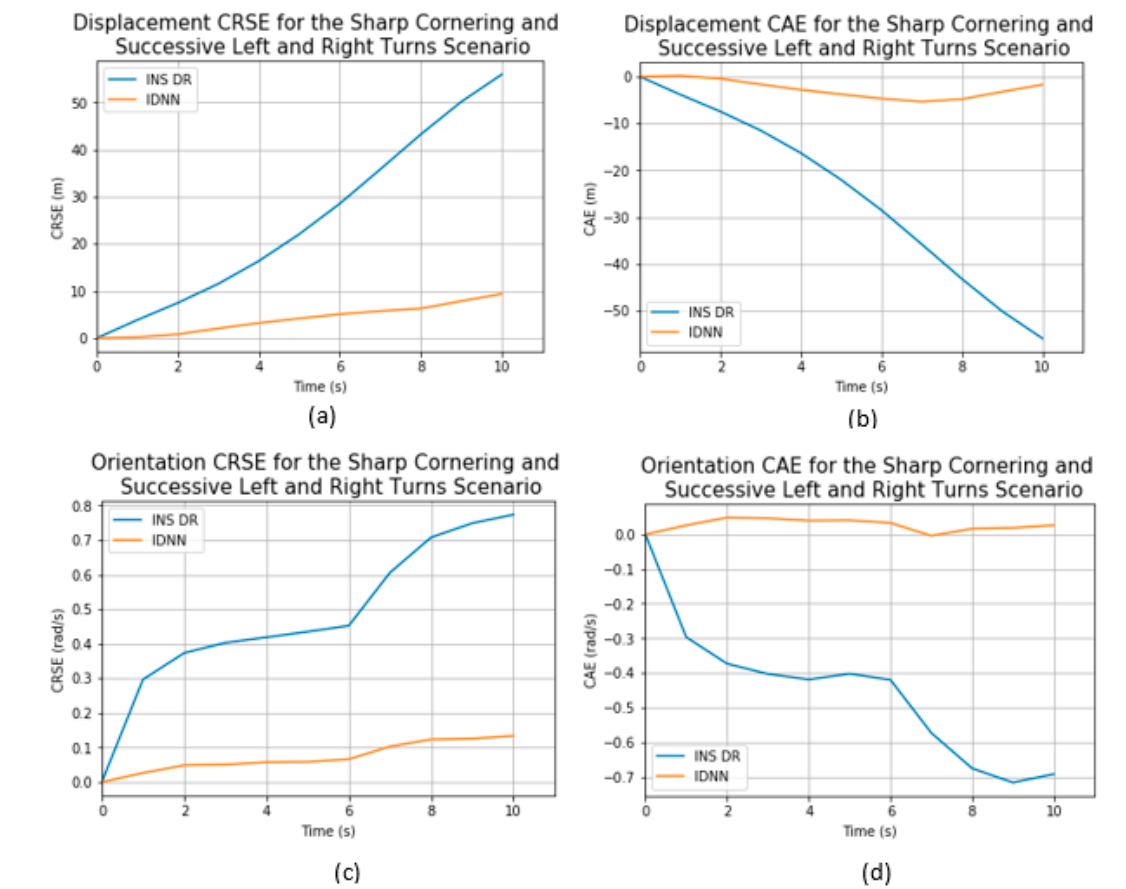
Figure 12. Showing the evolution of the estimation error over time in the hard brake scenario based on the ( a ) Displacement CRSE, ( b ) Displacement CAE, ( c ) Orientation rate CRSE and ( d ) Orientation rate CAE.